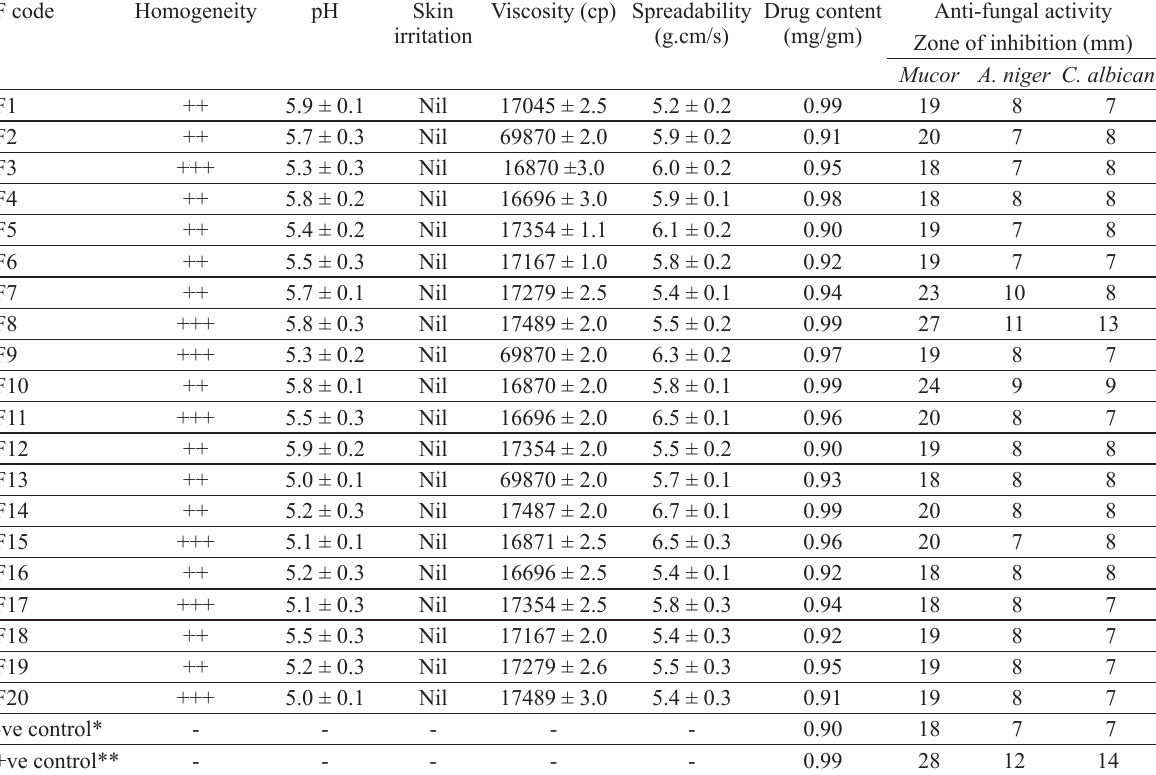
Characterization of Clotrimazole gel